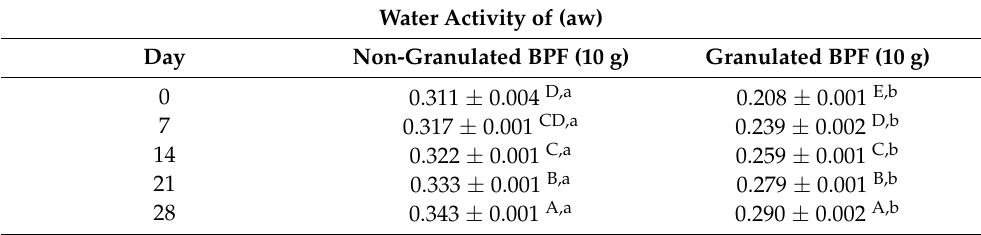
Table 1. Water activity of non-granulated and granulated BPF during a month of storage at 4 °C.